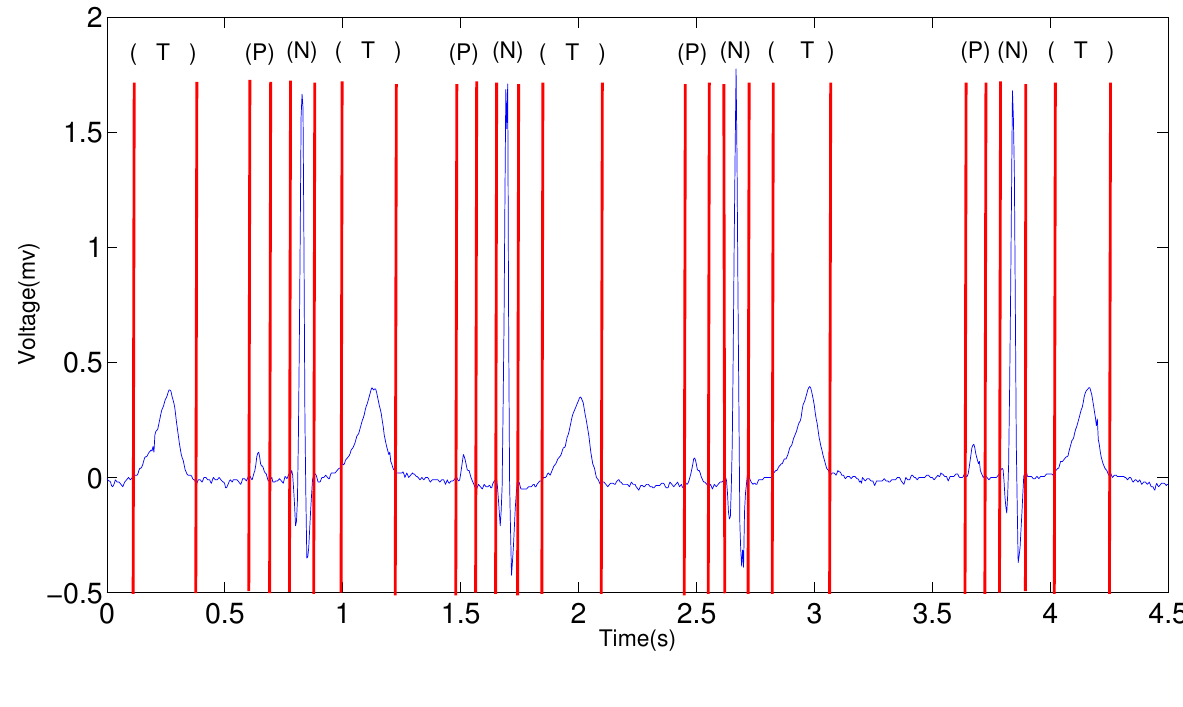
Figure 15. ECG segmentation using Layer 1 HMM. “P” stands for P subwave, “N” for a normal QRS complex, and “T” for T